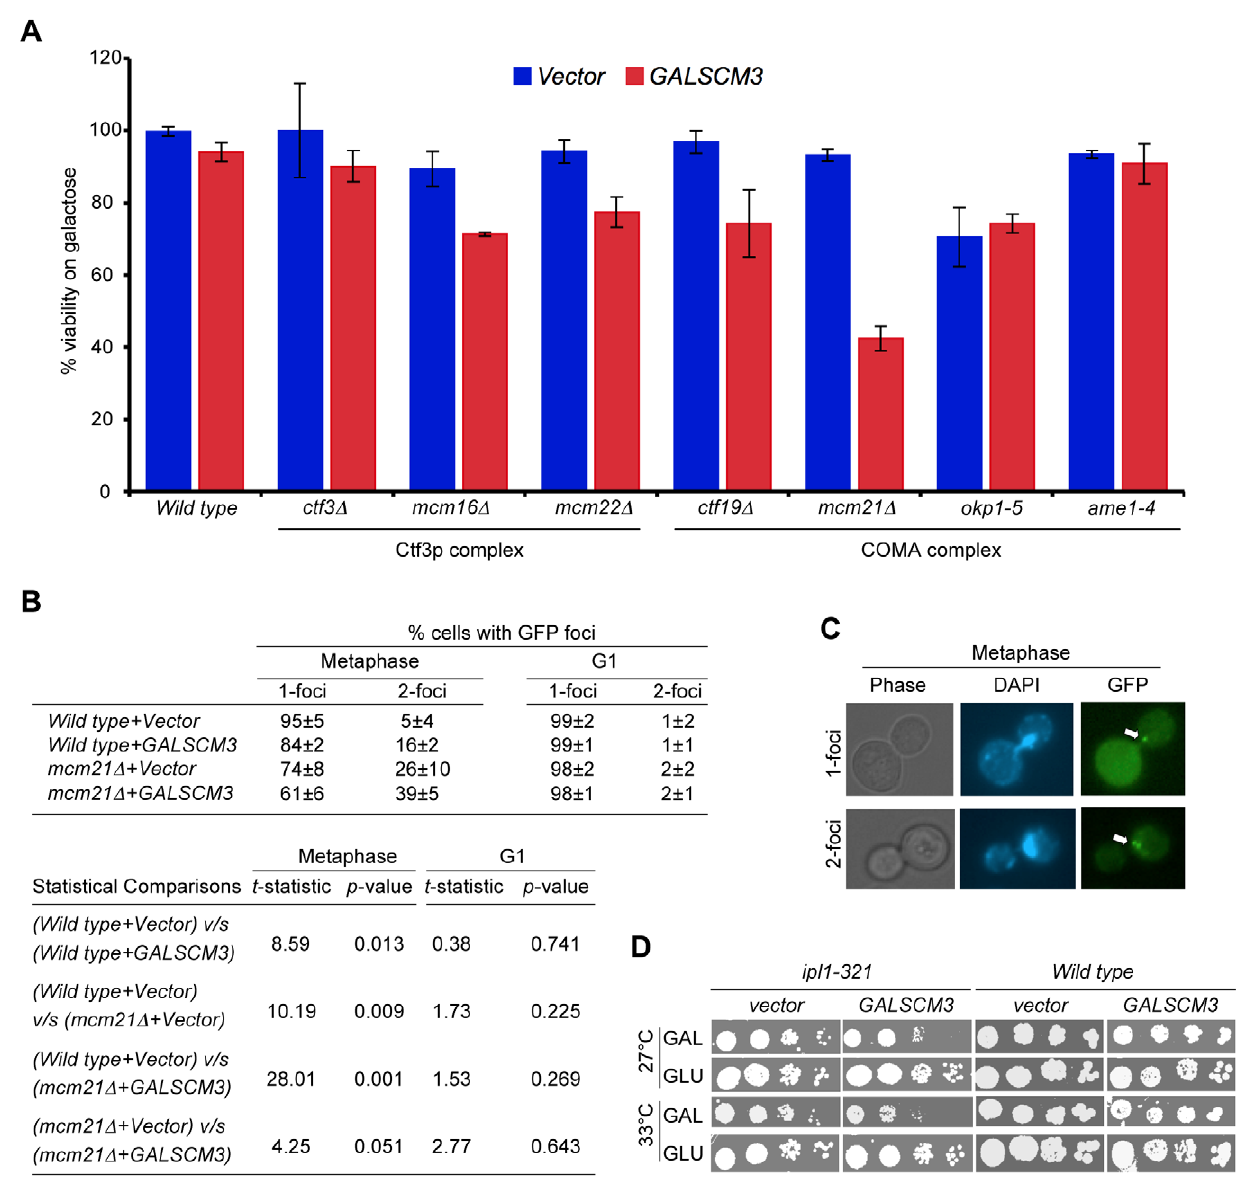
Figure 4. Overexpression of SCM3 causes reduced viability in a subset of kinetochore mutants and premature separation of sister chromatids. (A) GALSCM3 causes reduced viability in kinetochore mutants. A wild-type strain (Y5563) and kinetochore mutants ctf3 D (YPH1712), mcm16 D (YPH1714), mcm22 D (YPH1716), ctf19 D (YPH1713), mcm21 D (YPH1715), okp1-5 (YPH1678), and ame1-4 (YPH1676) were transformed with GALSCM3HA (pMB1306) or vector (pRS426 GAL1 ). Equal number of cells from three independent transformants for each strain were plated on SC-URA with either glucose (2%) or galactose (2%). At least 2500 colonies were counted and % viability is expressed as the ratio of the number of colonies on galactose over the glucose media. (B) Overexpression of SCM3 leads to premature separation of sister chromatids in metaphase. Sister chromatid separation was monitored in nocodazole-arrested (metaphase) and alpha factor arrested (G1) cells by counting the number of GFP-LacI foci at the marked pericentromere of ChrIV in a wild-type (SBY818) and mcm21 D (SBY1897) strains overexpressing SCM3 (pMB1306) or a vector (pRS426 GAL1 ). At least 300 cells were analyzed for each strain. Pair-wise comparisons using Student’s t -test were done to determine the statistical significance between samples. (C) Representative images of metaphase cells showing 1- and 2-GFP LacI foci (see, white arrows) are shown. (D) Overexpression of SCM3 causes lethality in ipl1-321 strain. Serial dilutions (5-fold) of ipl1-321 (SBY630) and wild type (SBY3) strains containing GALSCM3HA (pMB1306) or a vector (pRS426 GAL1 ) were plated on SC-URA with glucose (2%) or galactose (2%) plates and grown at 27 u C and 33 u C for 5